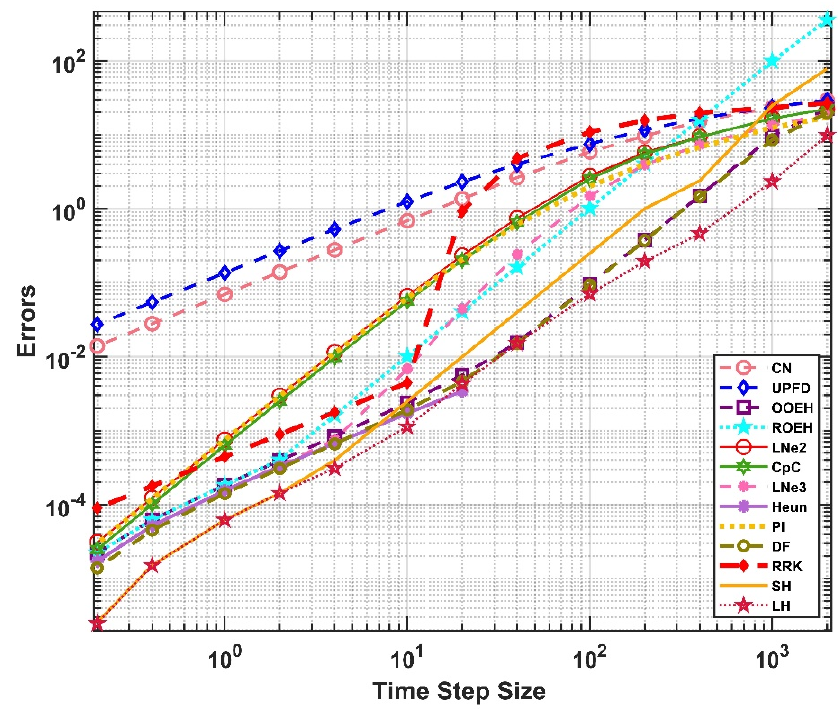
Δ for the non-equidistant